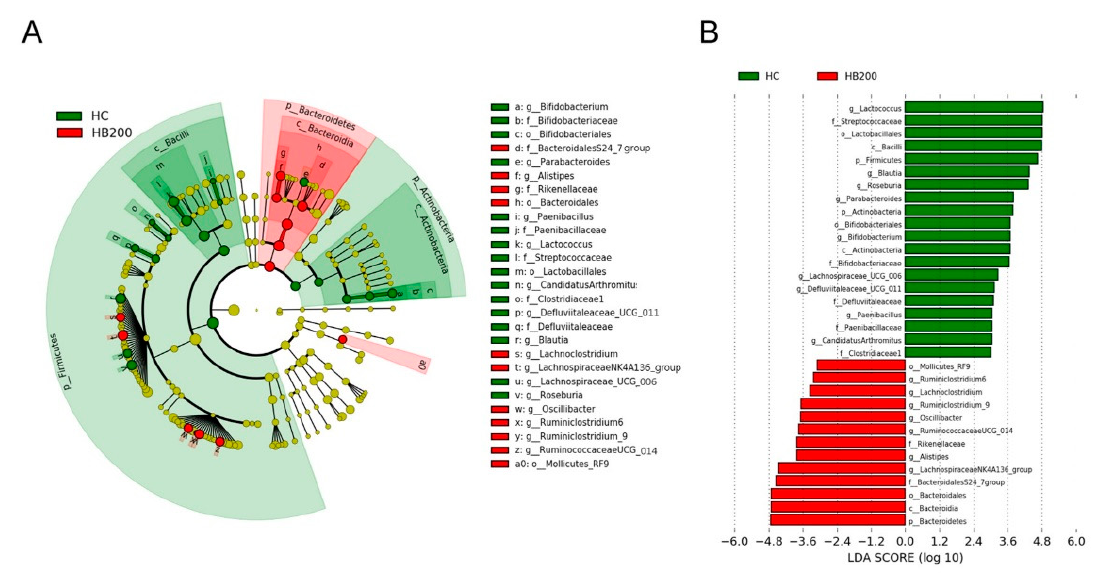
Figure 7. ( A ) Taxonomic cladogram and ( B ) linear discriminant analysis (LDA), obtained from LEfSe analysis of the gut microbiota in HC and HB200 groups. The only taxa meeting an LDA-significant threshold of >3 are shown.